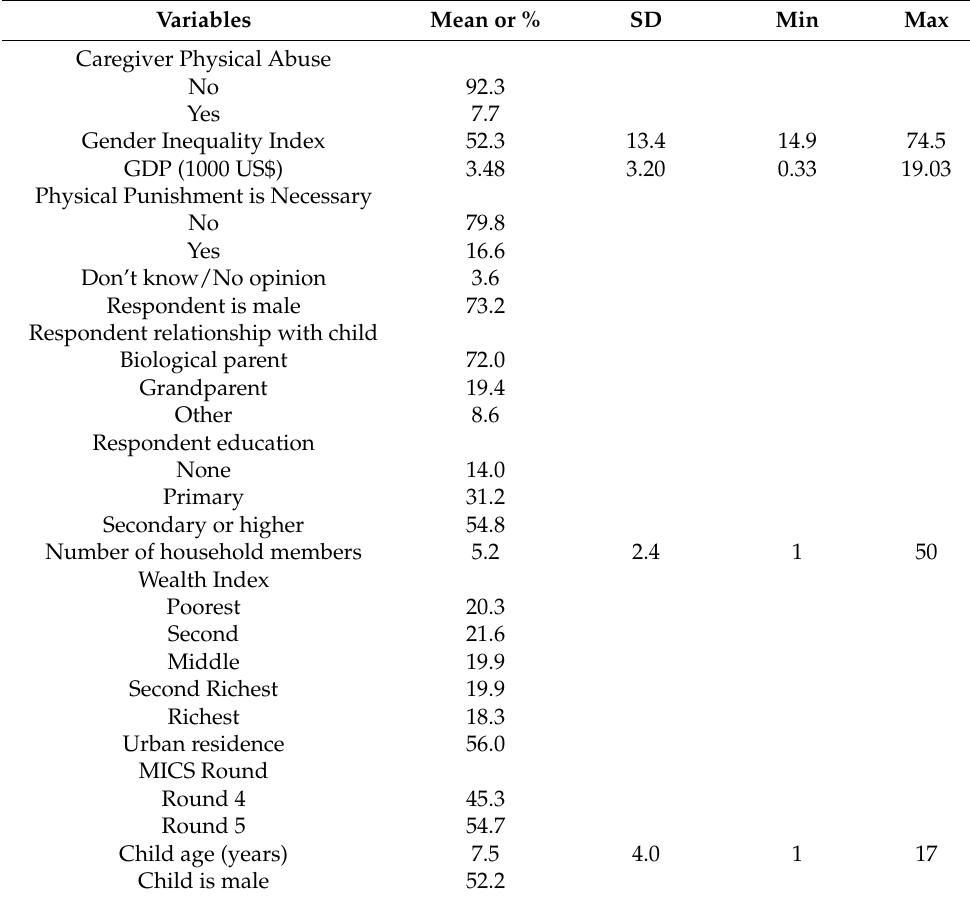
Table 1. Descriptive Characteristics of Study Participants ( N =